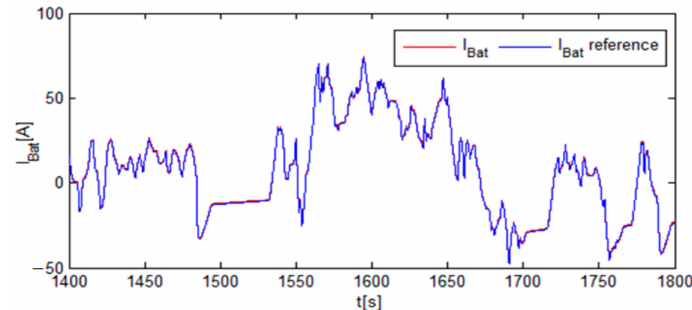
Figure 20. Zoom on the batteries current control result.